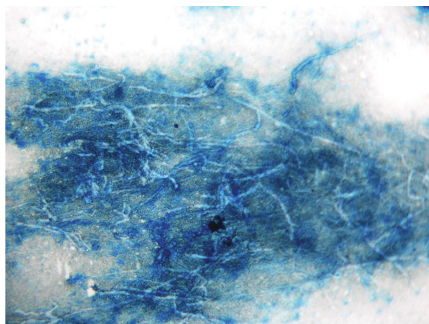
Figure 3: Microphotograph of histopathological examination of CT-guided tru-cut biopsy showing branching filamentous fungi with septate hyphae with finger-like branching at acute angles (lactophenol cotton blue stain,